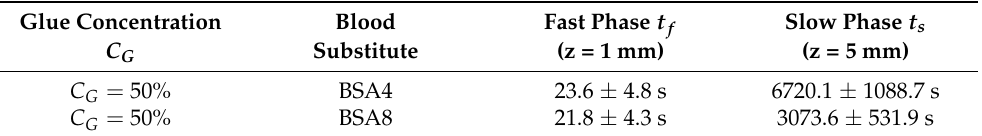
Figure 6. Time evolution of intensity change in C=C during the fast ( a ) and slow ( b ) polymerization phases of the GO mixture C G = 50% in contact with BSA4 and BSA8, respectively. Table 2. Characteristic polymerization time of fast and slow phases ( t f and t s ) for the GO mixture C G = 50% in contact with BSA4 and BSA8,